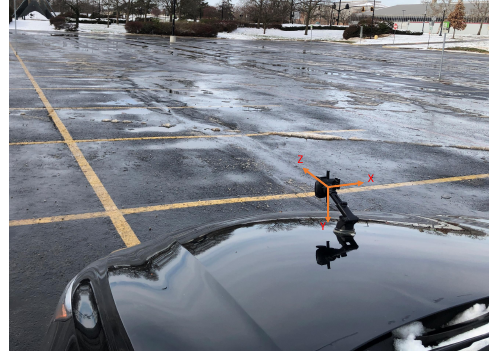
Figure 5. Dataset collection platform with predefined camera coordinates with respect to vehicle moving forward direction, x, y and z axis point at right, down and forward